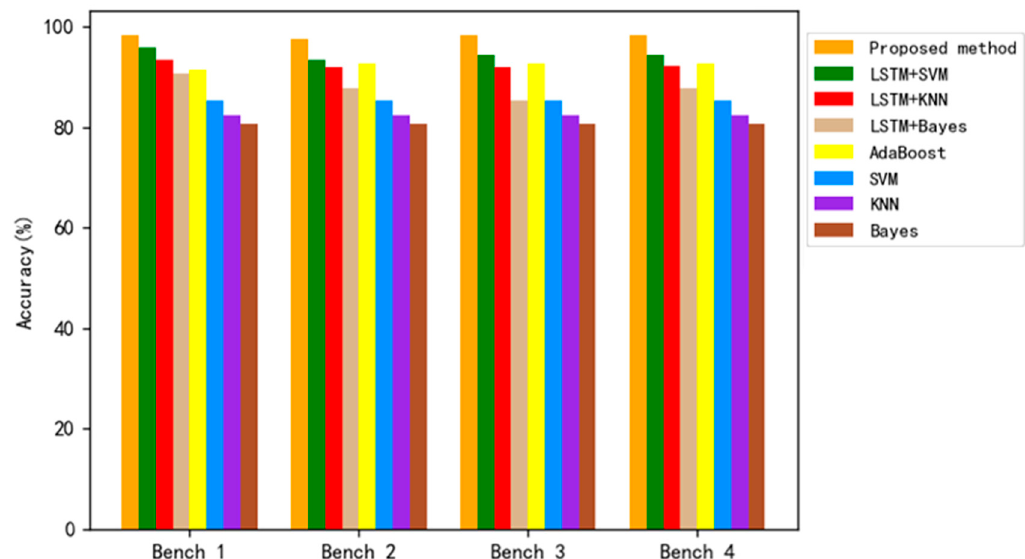
Figure 14. Diagnosis accuracy of all methods.